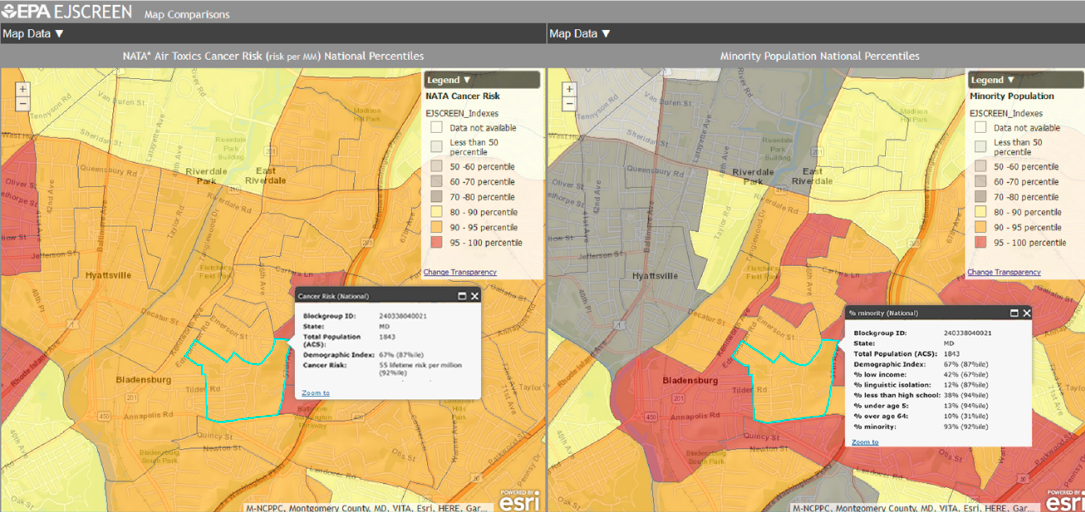
Figure 7 . EPA EJSCREEN side-by-side maps displaying national percentiles for NATA air Figure 7. EPA EJSCREEN side-by-side maps displaying national percentiles for NATA air toxics cancer toxics cancer risk ( left ) and non-White population ( right ). risk ( left ) and non-White population ( right